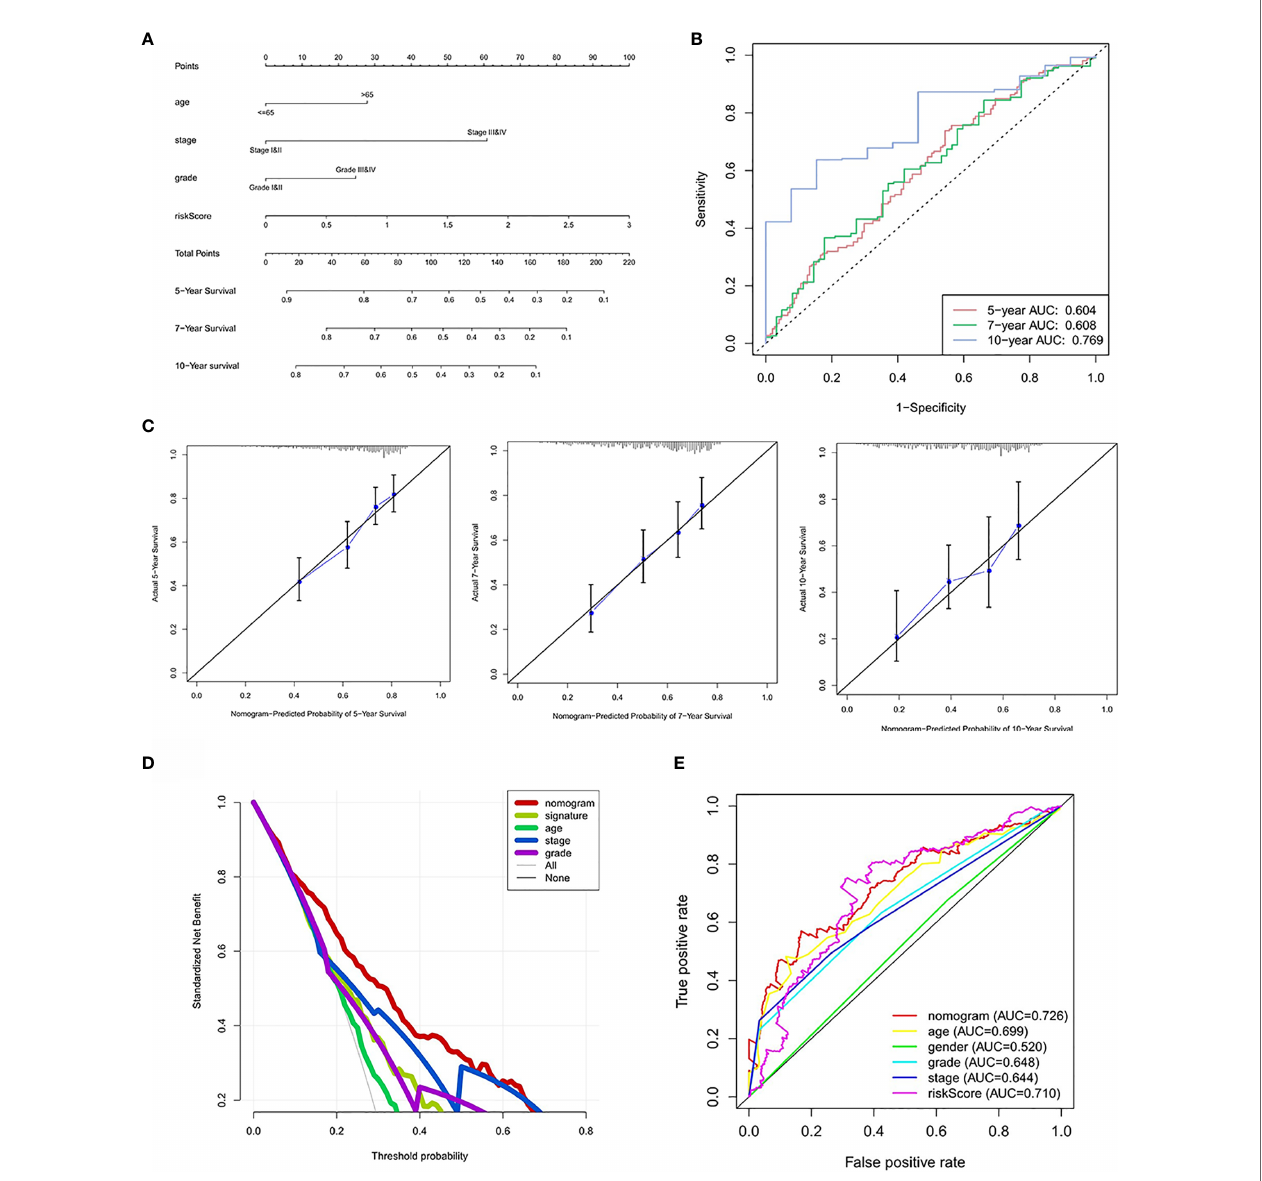
FIGURE 9 | Nomogram construction and performance test. (A) Nomogram based on risk score, age, stage, and grade. (B) Time-dependent ROC curves demonstrate the performance of the nomogram in up to 10-year follow-up. (C) Calibration curves of the nomogram for predicting the survival outcomes at 5, 7 and 10 years. The 45-degree line represents the ideal prediction. (D) Decision curve analyses curve of the nomograms. (E) ROC curves demonstrate the performance of the nomogram, signature and clinicopathological variables in up to 10-year